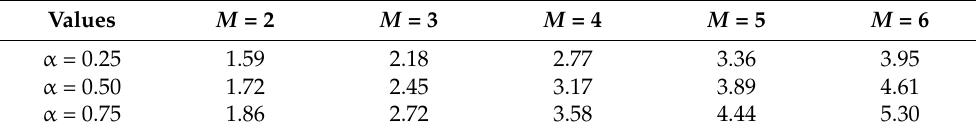
Table 2. Multiple of computation for M -piecewise